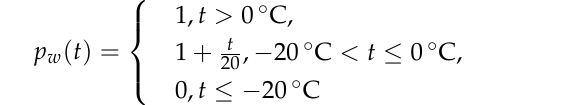
Table 3. The distribution of clouds in different weather conditions and Earth regions. Region Equator No clouds Cumulus (Cu) Middle zone North Layered (St)